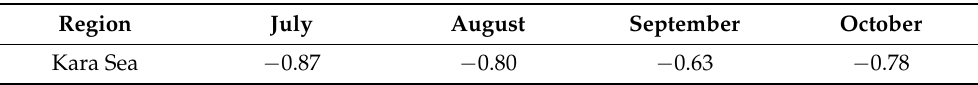
Table 2. Correlation coefficients between the sum of frost degree-days and sea ice extent in July–October (1979–2021).